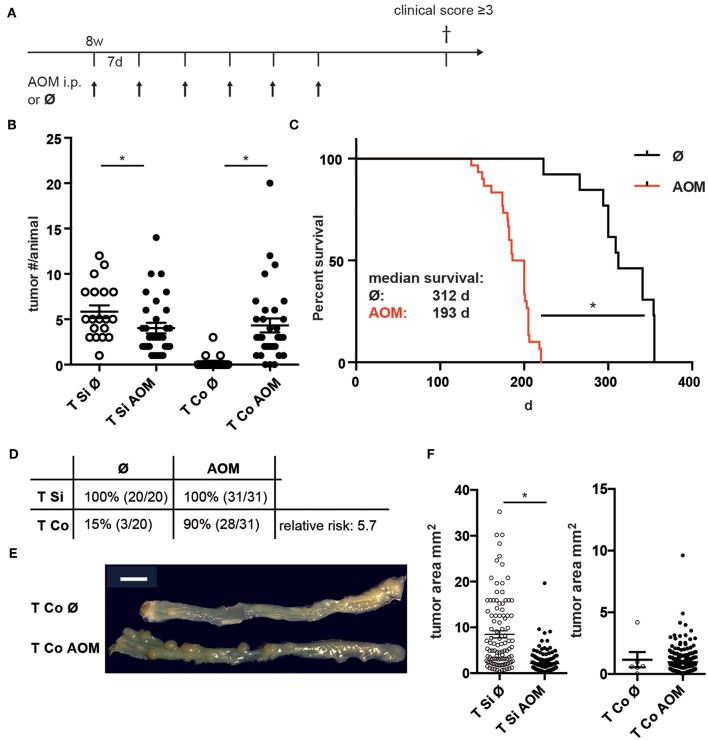
Increased incidence and number of colon tumors in AOM-treated APC1638N/+ mice. (A) Experimental scheme. Apc1638N/+ mice received weekly i.p. injections of AOM from age 8 to 14 weeks and were sacrificed when reaching criteria for euthanasia. (B) Number of tumors in small intestine (Si) and colon (Co) in untreated (n = 19) and AOM-treated (n = 31) mice (Mann–Whitney test). (C) Kaplan-Meier survival analysis (log-rank test). (D) Tumor incidence in Si and Co (Chi-square analysis). (E) Representative macroscopic image of colon tumors in untreated and AOM-treated Apc1638N/+ mice. Scale bar: 1 cm. (F) Tumor sizes of Si and Co tumors (Si untreated: n = 103, Si AOM: n = 150, Co untreated: n = 5, Co AOM: n = 189, *p < 0.0001, Mann–Whitney test). *p < 0.05.